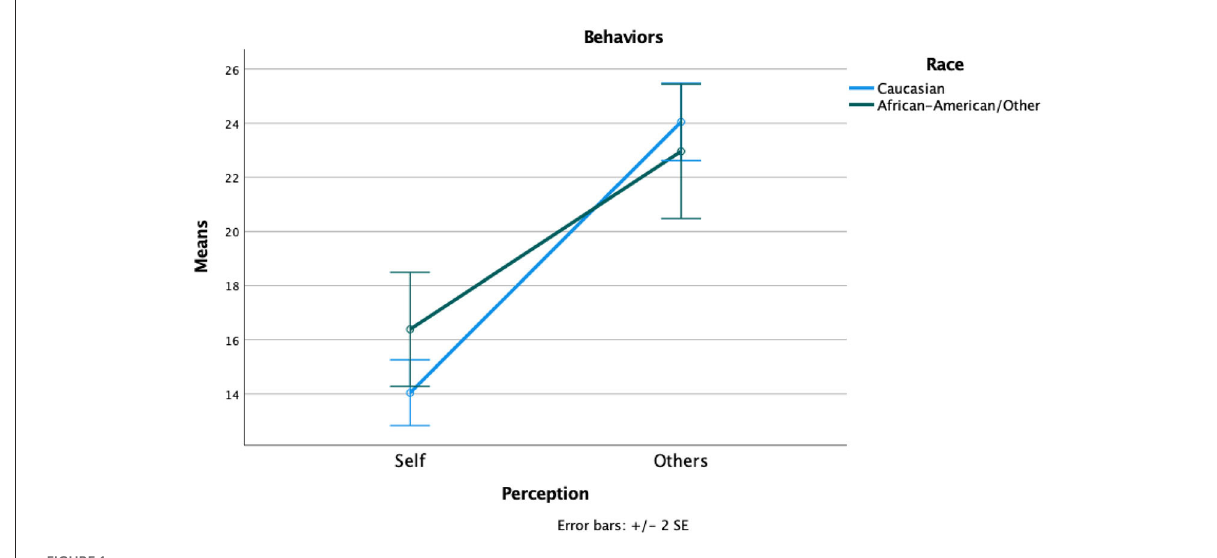
FIGURE1 Spectator behavior means comparison by identified